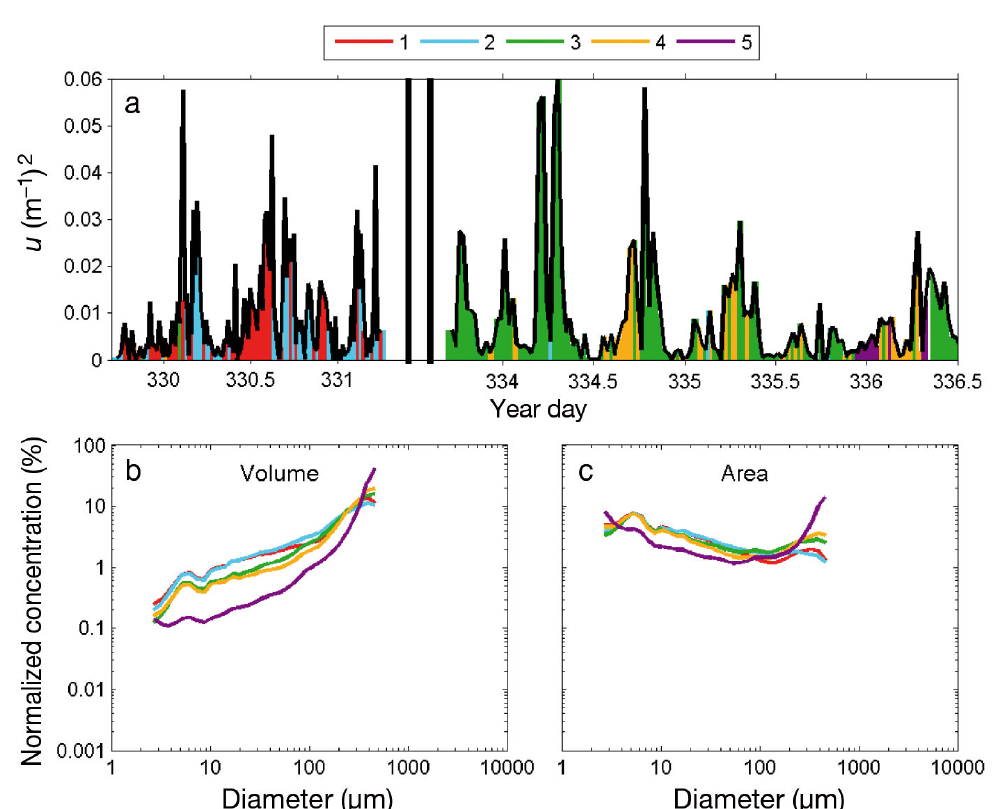
Fig. 5. Particle size distri- butions (n = 634) sorted into 5 groups using en- tropy analysis. (a) Particle size distribution within each group versus the square of the velocity from the acoustic Doppler cur- rent profiler (ADCP) for currents throughout the 2 deployment periods (no. 1, left; no. 2, right). (b,c) Mean par ticle size distribu- tions per group, presented as normalized (b) volume and (c) area concentration. See Table 1 for percent- ages of single grains, mi- croflocs and macroflocs in each